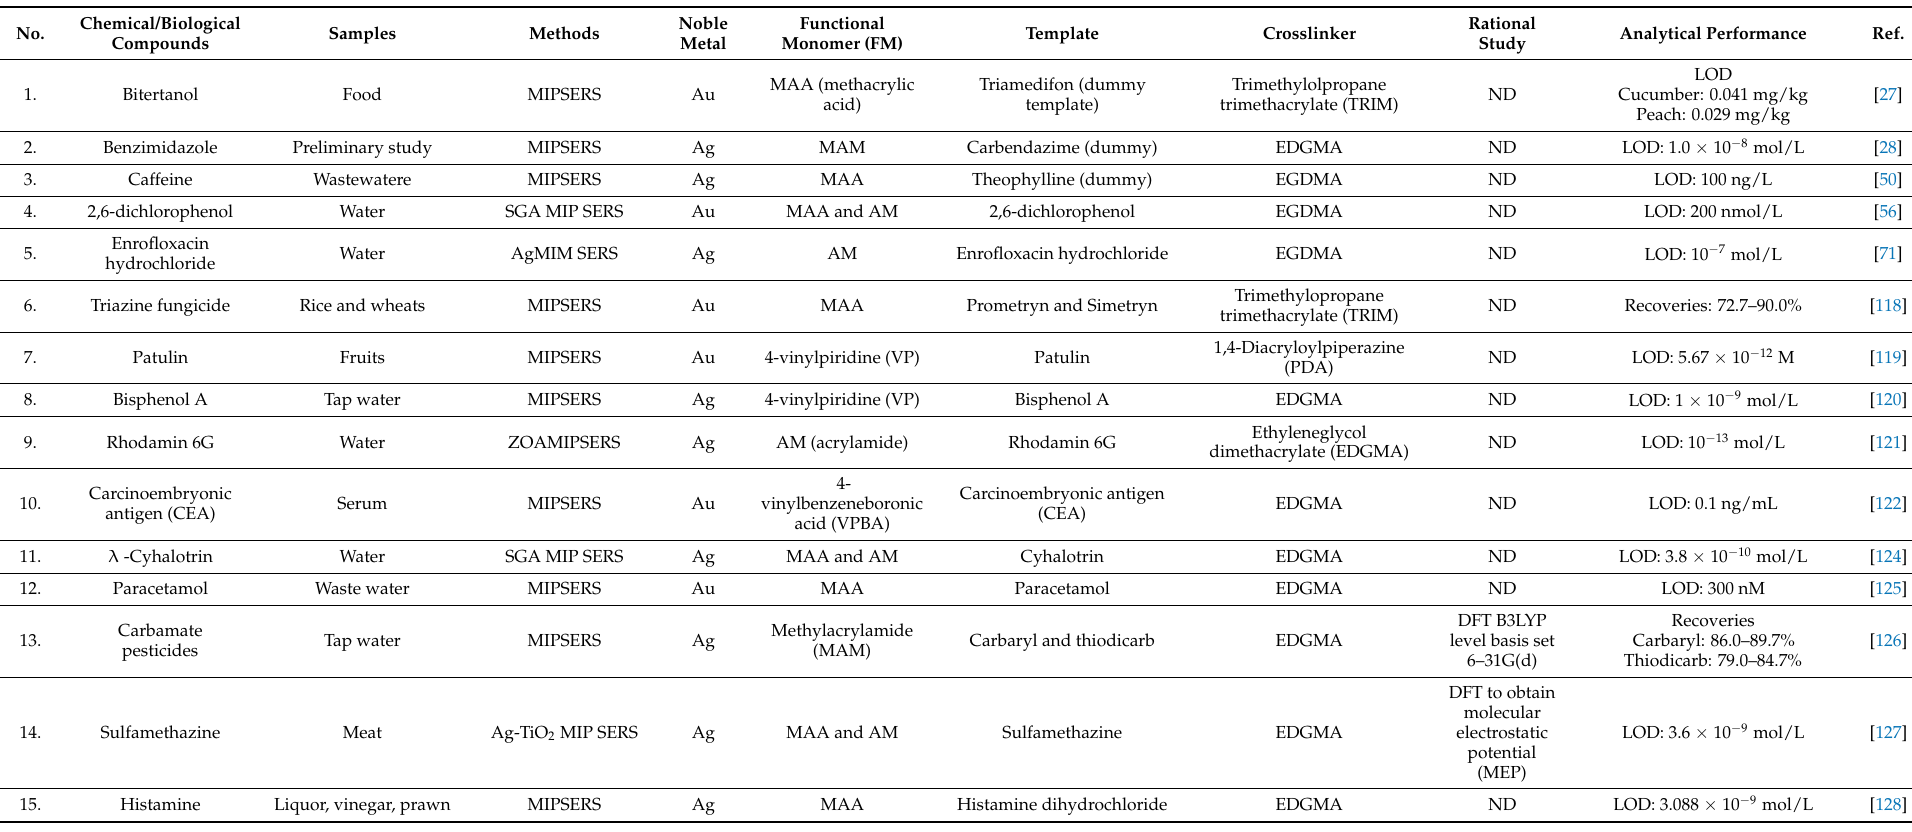
Table 1. MIPSERS application in